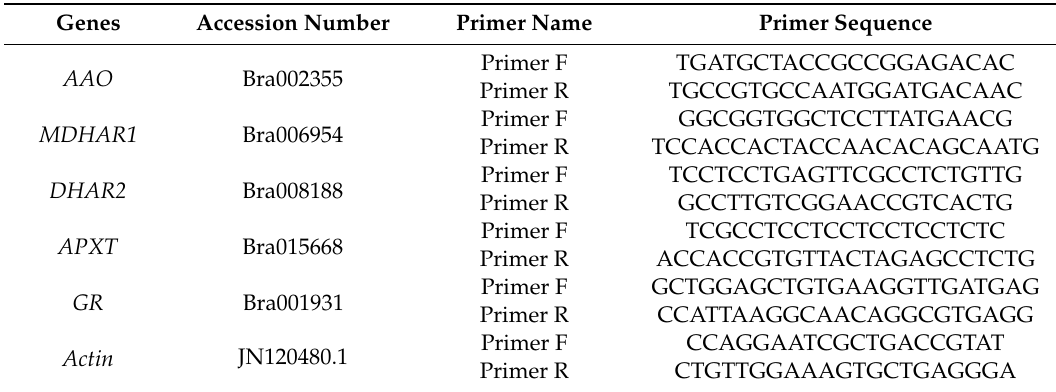
Table 1. Gene specific primers used for real-time